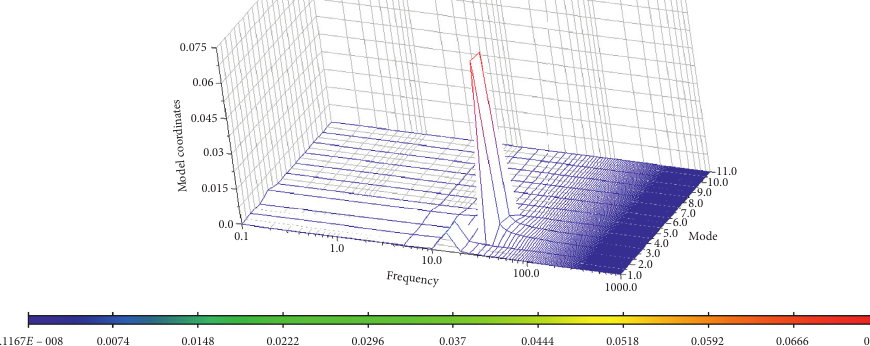
Figure 13: The frequency response of the centroid of the dispersing